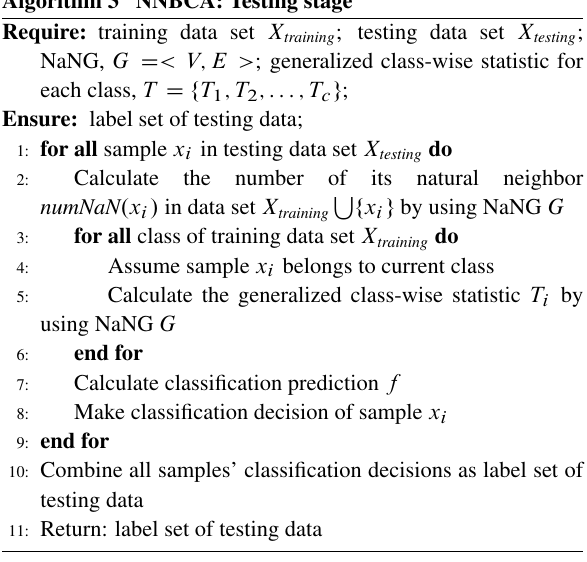
Algorithm 3 is the description of the NNBCA classification algorithm in the testing stage.